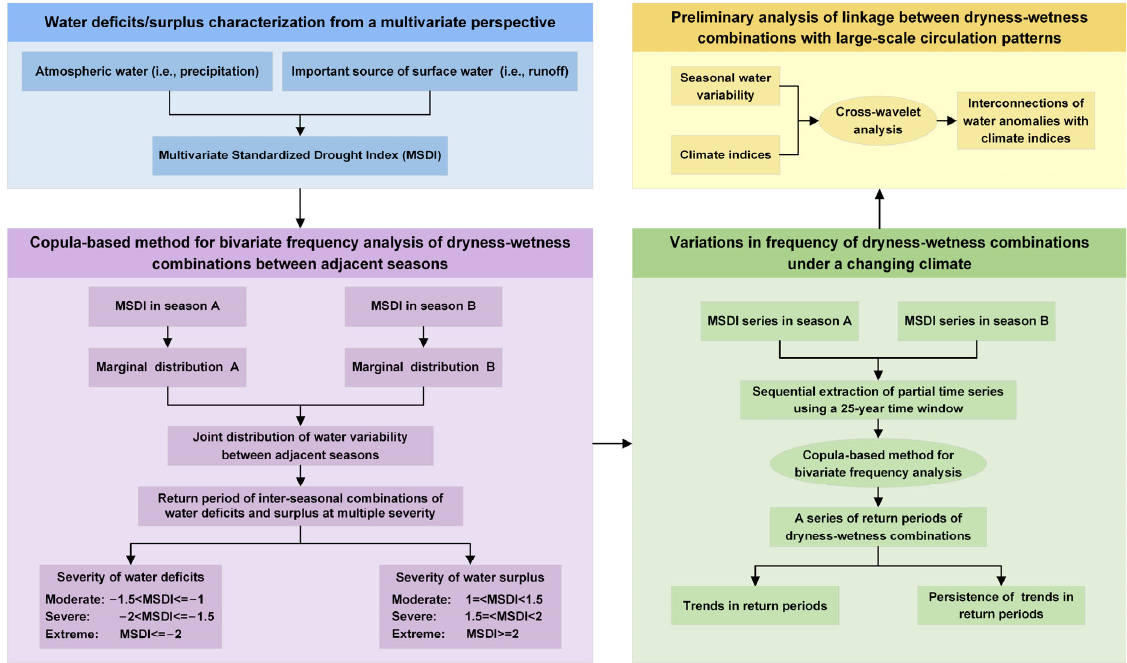
Figure 2. A flowchart illustrating procedures for hazard assessment of dryness–wetness combina ‐ tions between adjacent